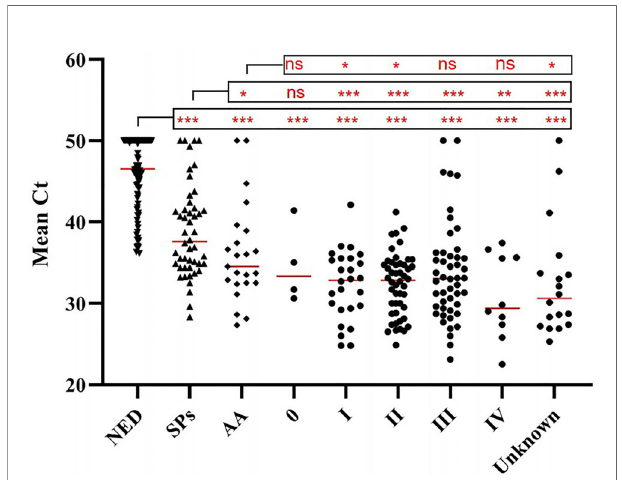
FIGURE 3 | Methylation levels (mean Ct values) of CLIP4 gene in stool samples from NED subjects, as well as SP, AA and CRC patients of different stages. Horizontal red bars denote the median value of mean Ct values of all samples within the group. ns, not signi fi cant. * p < 0.05, ** p < 0.01, *** p <